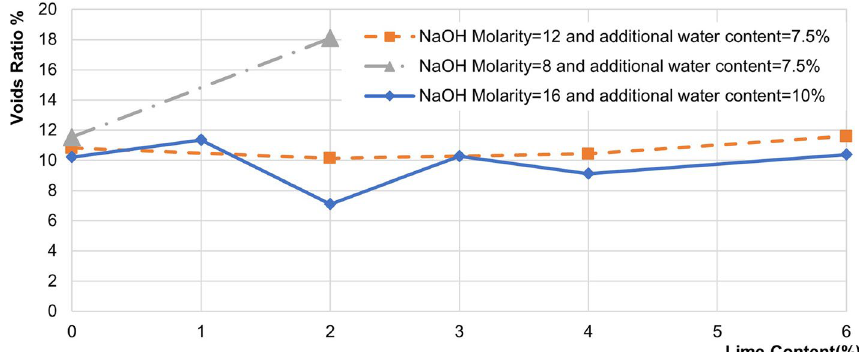
Fig. 7 The relation between lime content and void ratio % at 90 days from casting for different NaOH molarities and different additional water